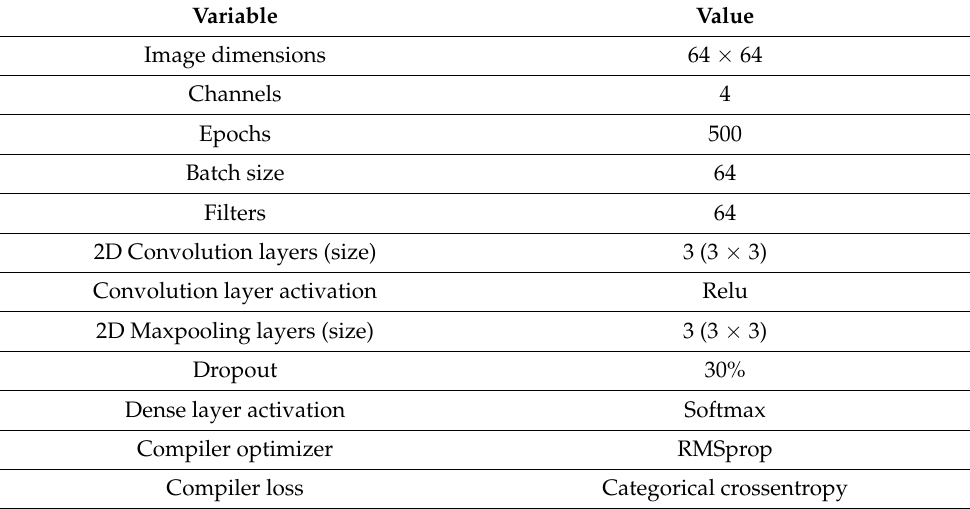
Table 2. Properties of the employed CNN